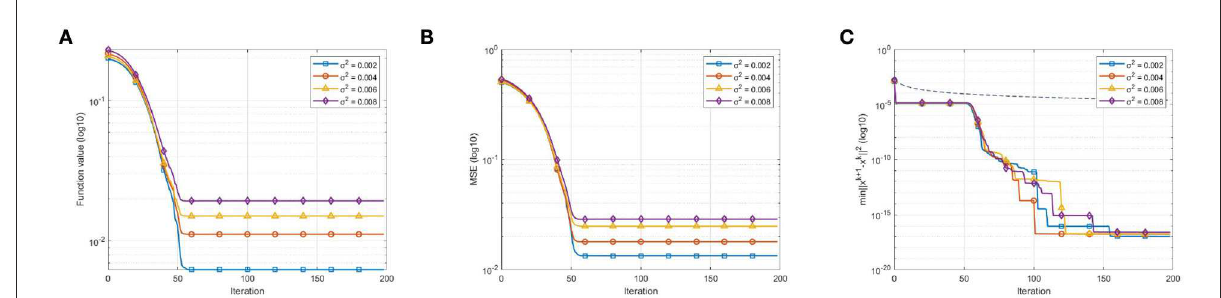
FIGURE1 Convergence behavior in the case of noisy data: (A) Function value vs. number of iterations, demonstrates the sufficient desent and convergent f ( x k ) property of the function value sequence ; (B) MSE vs. number of iterations, demonstrates the convergent property of the point { }